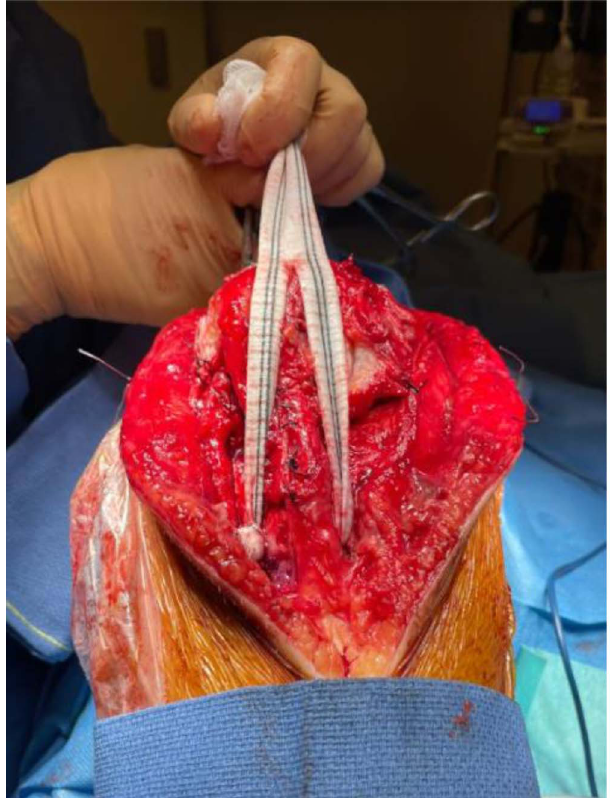
Figure 14. The vascular graft is oriented along the extensor apparatus, embracing the patellar tendon from both sides, while converging at a midpatellar level.